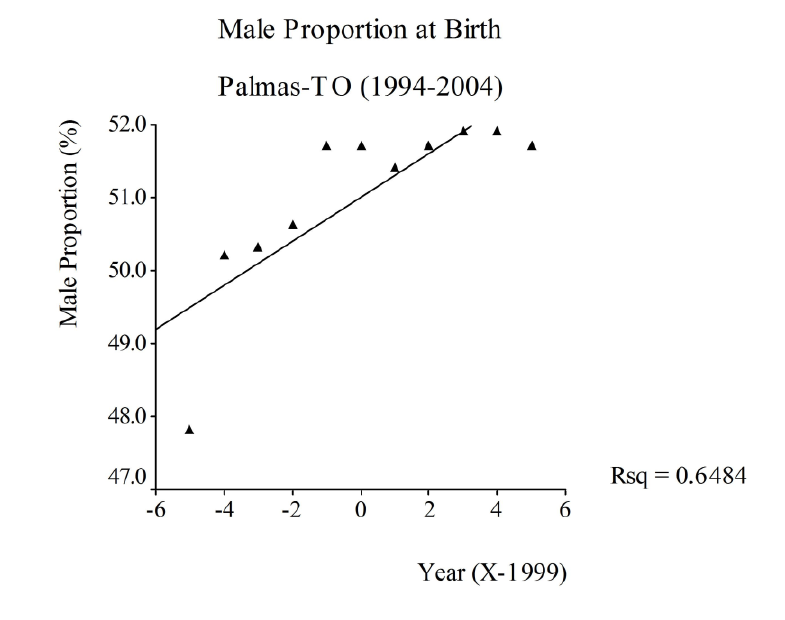
Figure 4. Time trend of male proportion at birth, Brazil, Palmas-TO,